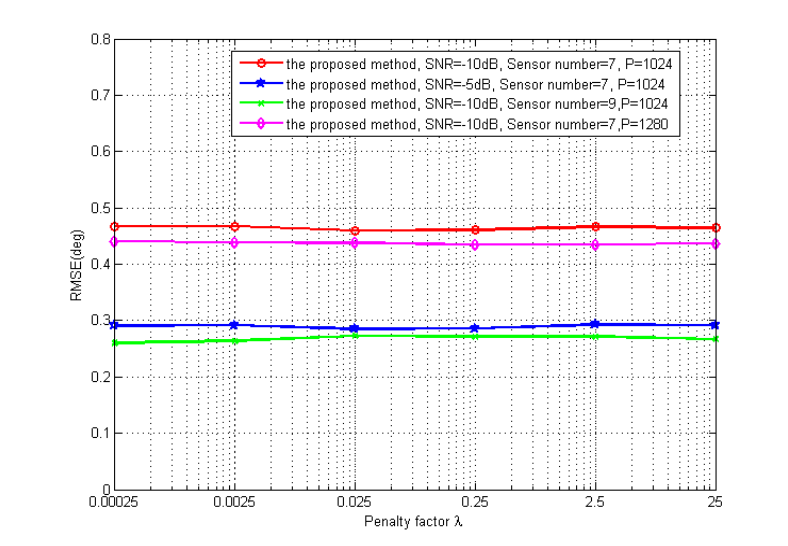
Figure 11. RMSE of the DOA estimations vs. the penalty factor λ .